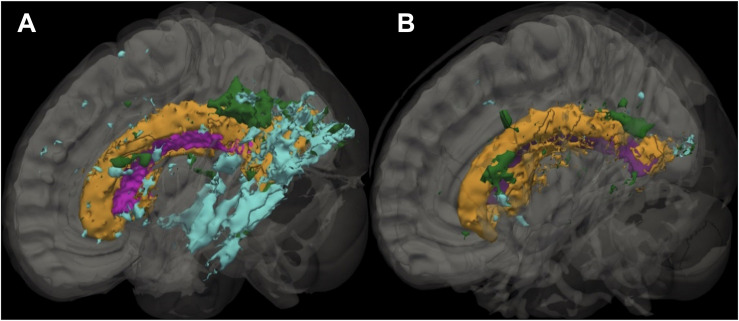
Sagittal slice showing the distribution of leukoaraiosis (LA) in periventricular, deep, and infracortical brain regions of individuals with atrial fibrillation (left; n = 17) and non-atrial fibrillation peers (right; n = 17). Representative participant brain for participants with AF (A) and non-AF peers (B) with the ventricle (purple) and leukoaraiosis segmented by depth: periventricular (orange), deep (green), and infracortical (blue).